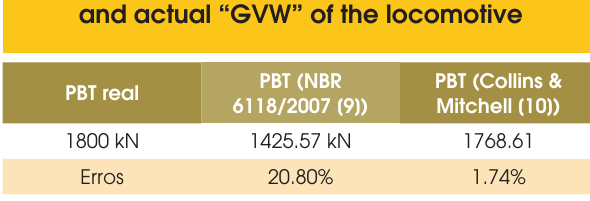
Figure 16 – Steel's stress-strain diagram in reinforced concrete